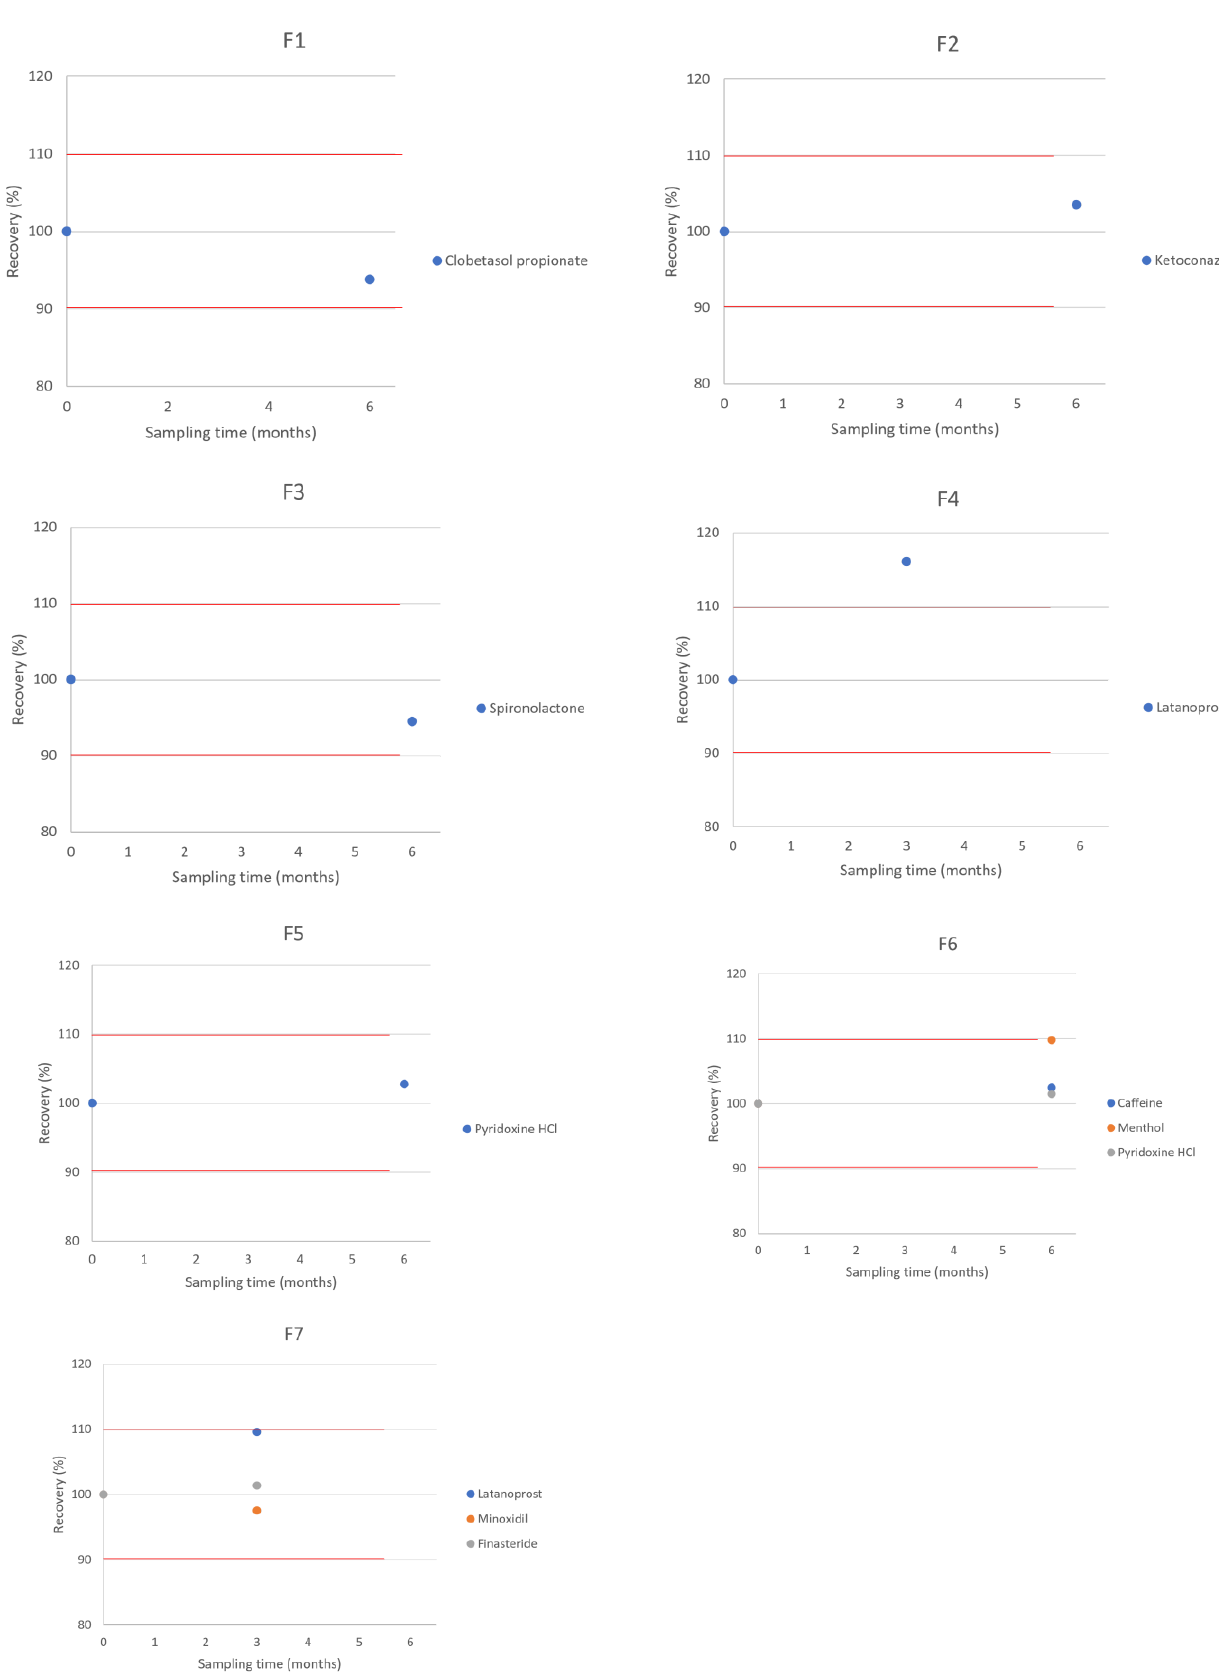
Figure 1. Compatibility of the Selected APIs in the Hair Vehicles. Red lines represent the lower and upper limits, corresponding to 90% and 110% of labeled